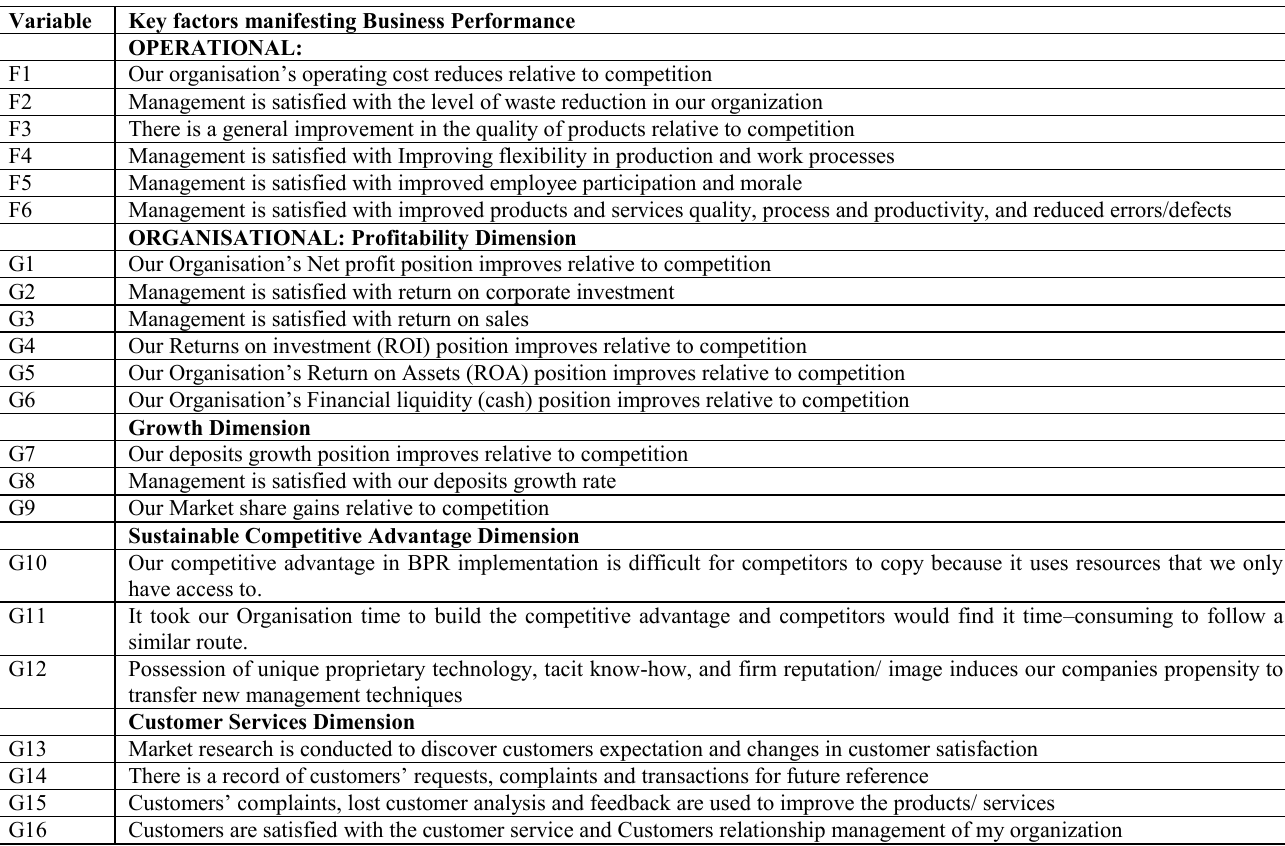
Table 2: The measure of performance